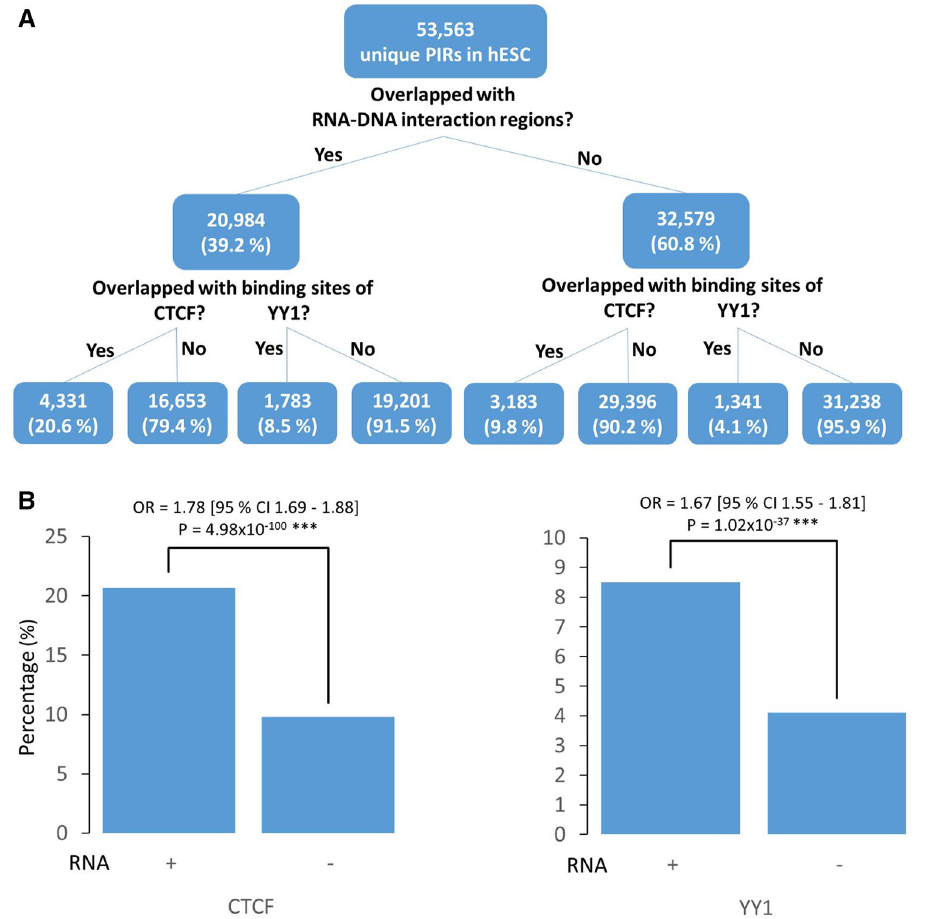
Figure 1. Enrichment of CTCF or YY1 binding sites in promoter interacting regions interacting with RNAs (RNA-PIRs). (A) Numbers and percentages of PIRs in human embryonic stem cells (hESCs) interacting with RNAs and containing binding sites of CTCF or YY1. (B) Odds Ratios (ORs) and p-values of CTCF or YY1 site enrichment were estimated from binary logistic regression analyses including PIR size as a covariate. ***p-values obtained from binary logistic regression analyses were lower than the p-values obtained from the same analyses performed with 1000 randomised CTCF or YY1 site sets (permutation P < 1.0x10 -3